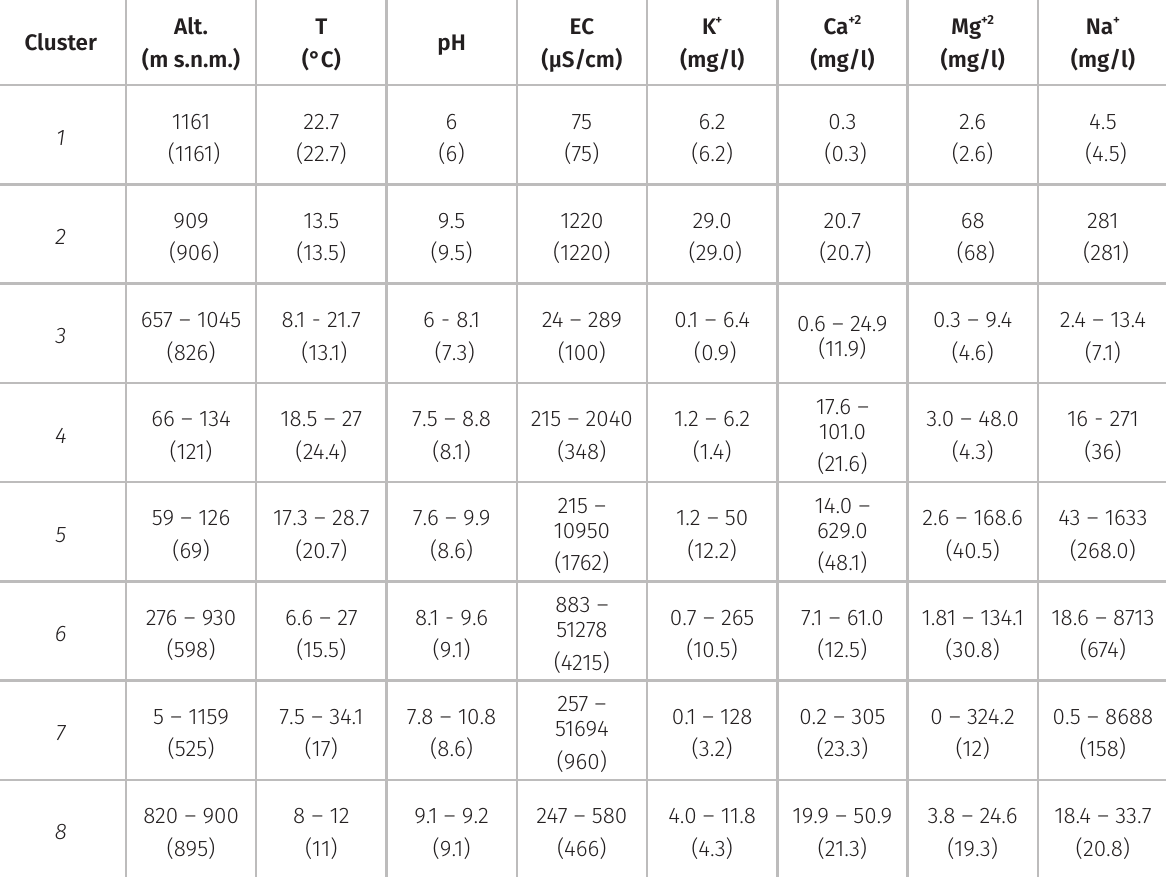
Table IV. Range of examined parameters in the different habitats of clusters, median values in parenthesis. Abbreviations: T = temperature, EC = electrical conductivity, Alt. = altitude.